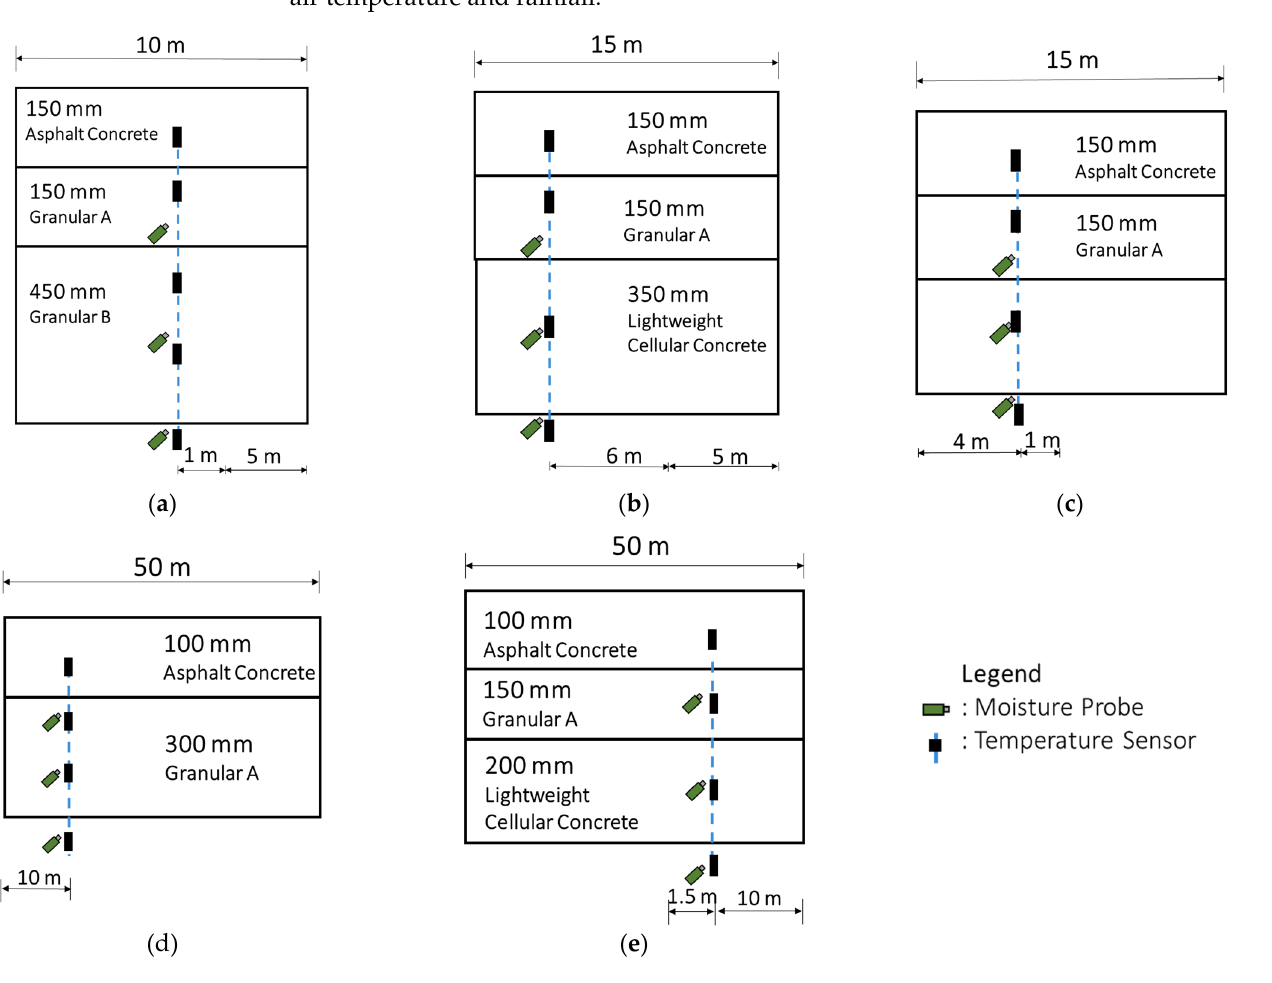
Figure 2. Cross section view of pavement sections at Erbsville and Notre Dame Drive (NDD): ( a ) Erbsville control section view; ( b ) Erbsville LCC350 section view; ( c ) Erbsville LCC250 section view; ( d ) NDD control section view; ( e ) NDD LCC400,475,600 typical section view.